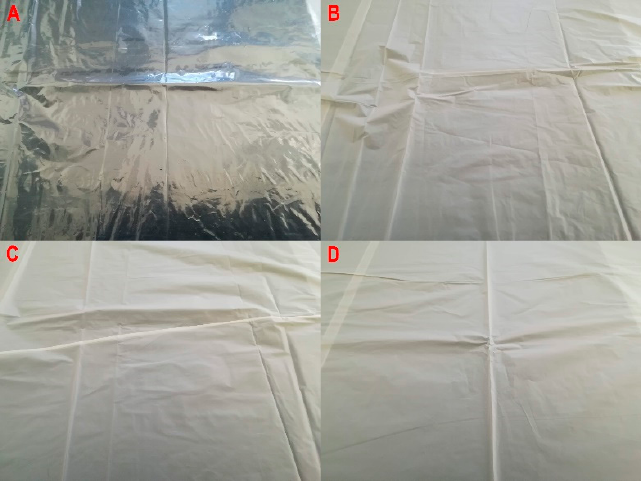
Figure 6. Dependence of the thickness of the obtained films on the rotational speed of the extruder screw.